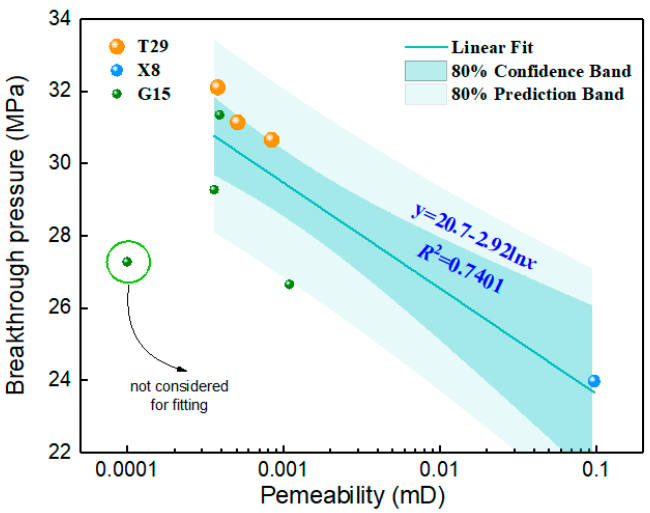
Figure 11. Relationship between breakthrough pressure and permeability.